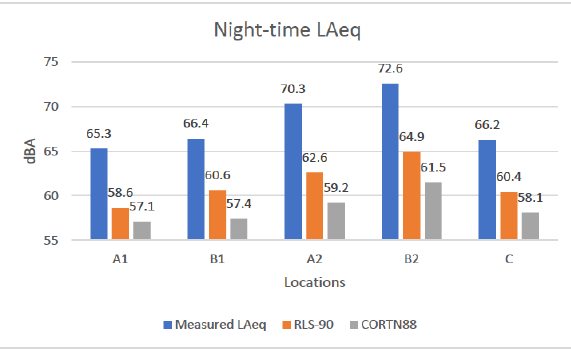
Figure 13: Chart showing a comparison between different standards for night-time